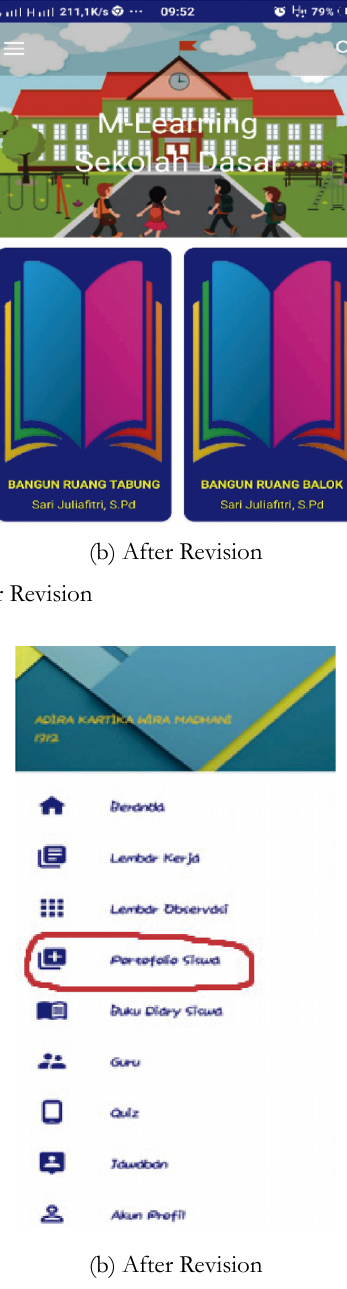
Figure 6 . Layout Before & After